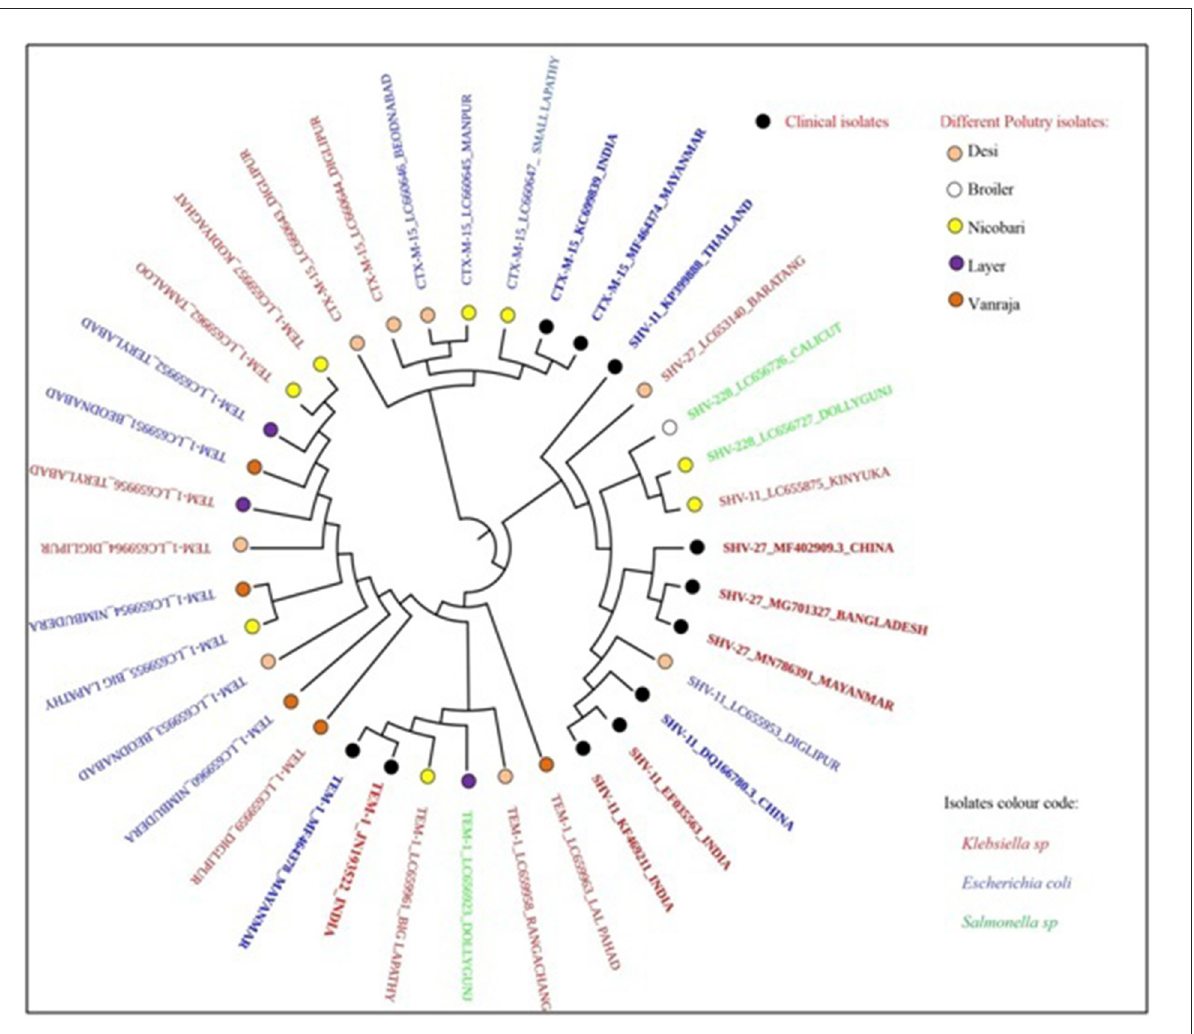
FIGURE4 Clonal relationship of β -lactamase-producing Enterobacteriaceae isolated from locally reared fowls in Andaman and Nicobar Islands (India) with human clinical